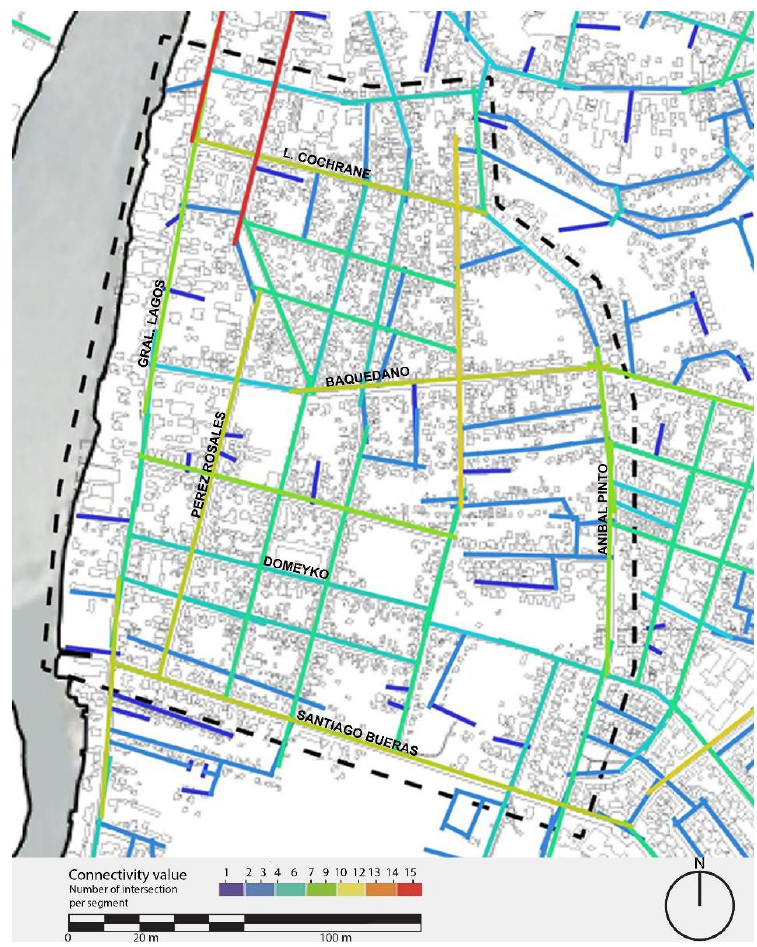
Figure 2. Connectivity map of the Barrios Bajos, Valdivia. Source: Authors. Table 2. Land use percentages and streets w ith a high diversity of land uses according to Simpson’s diversity index.